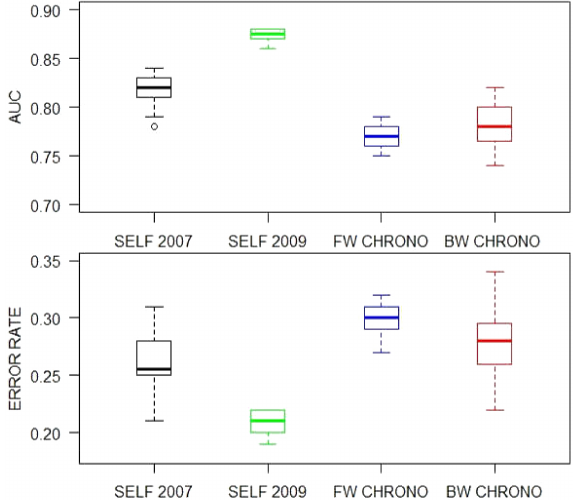
Figure 11. Distribution of the AUC and error rate values calculated on the 10 replicates for 2007 and 2009 modelling and 100 models during the chrono-validation process.